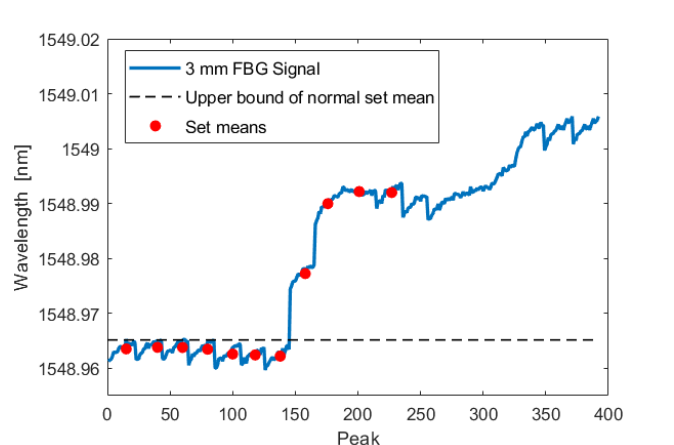
Figure 15. Crack detection analysis during low-amplitude cyclic loading for the FBG embedded 3 mm from the notch tip. For this and subsequent images, the dashed line represents three standard deviations above the normal set mean.